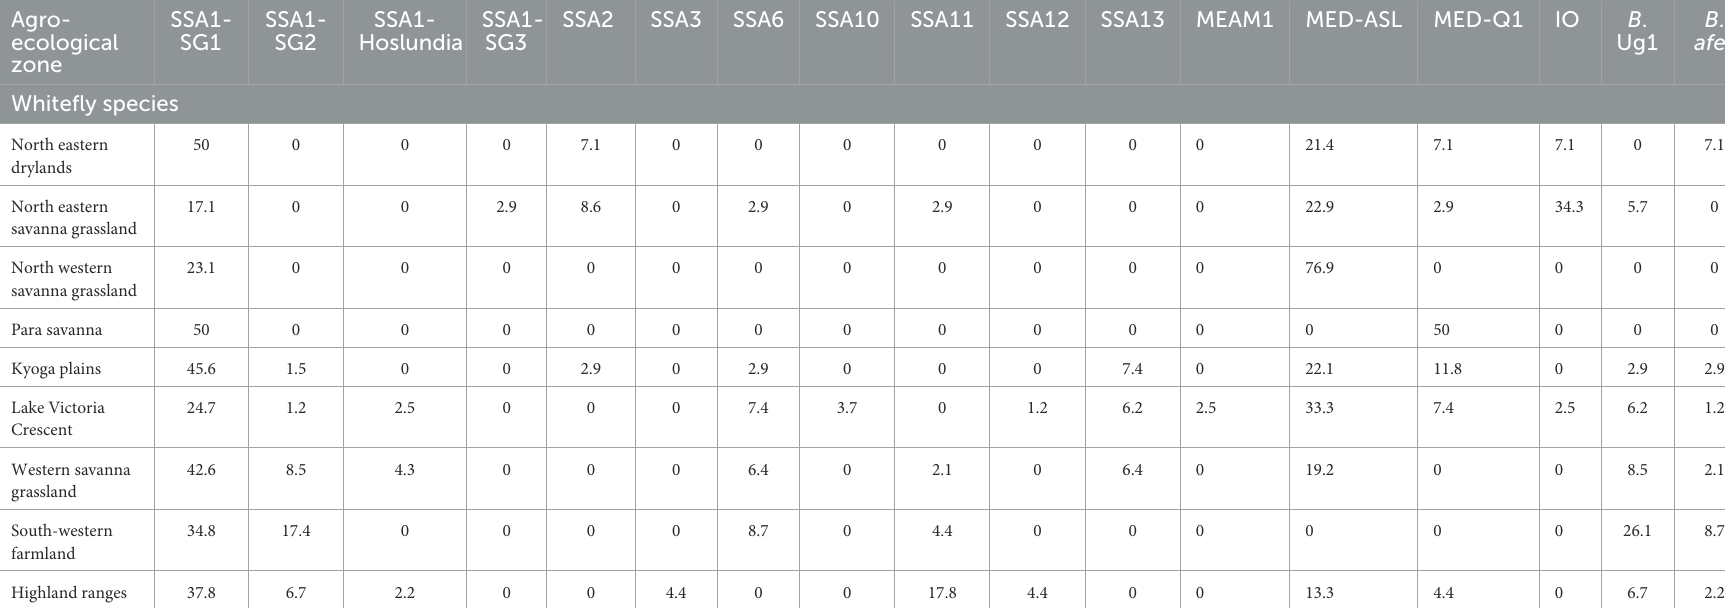
SSA1- SSA1- SSA1- SSA1- SSA2 SSA3 SSA6 SG1 SG2 Hoslundia SG3